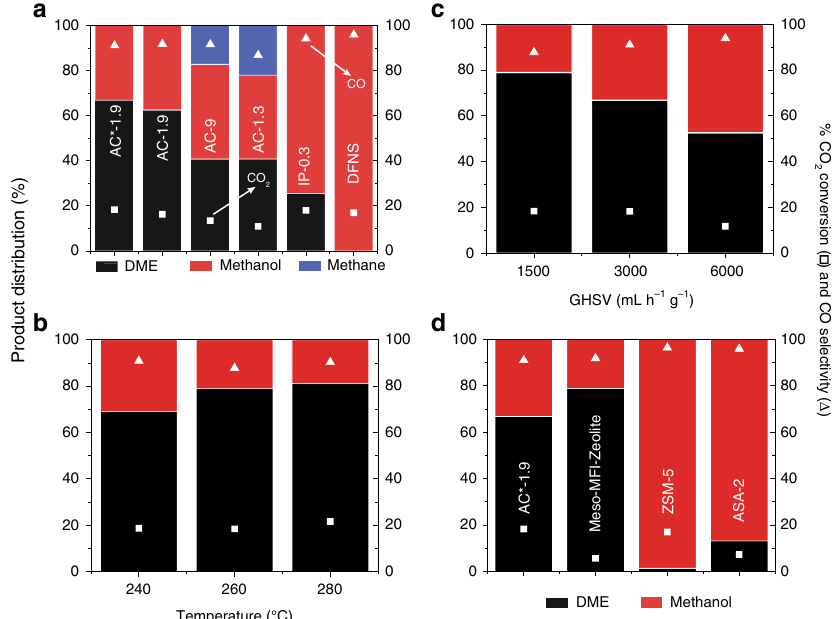
Fig. 10 AAS catalyzed CO 2 to DME conversion. a CO 2 conversion, CO selectivity, and product distribution (DME, methanol, and methane) of various Cu- Zn-Al/AAS hybrid catalysts; b effect of GHSV; and c Effect of temperature on the product distribution (DME and methanol) of CO 2 hydrogenation using AC*-1.9 as a catalyst. d CO 2 conversion, CO selectivity, and product distribution (DME and methanol) of various Cu-Zn-Al/aluminosilicate hybrid catalysts. Square and triangle symbol represent CO 2 conversion and CO selectivity. Error in the CO 2 conversion is ±10% and in the DME selectivity is